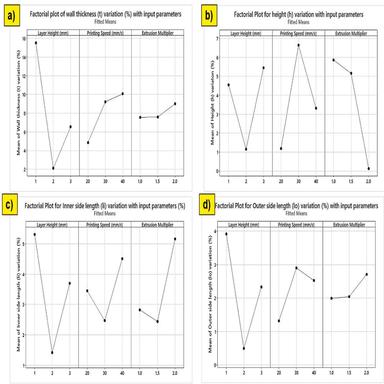
Line graph depicting mean dimensions of (a) wall thickness, (b) height, (c) inner side length, and (d) outer side length with change in printing parameters.